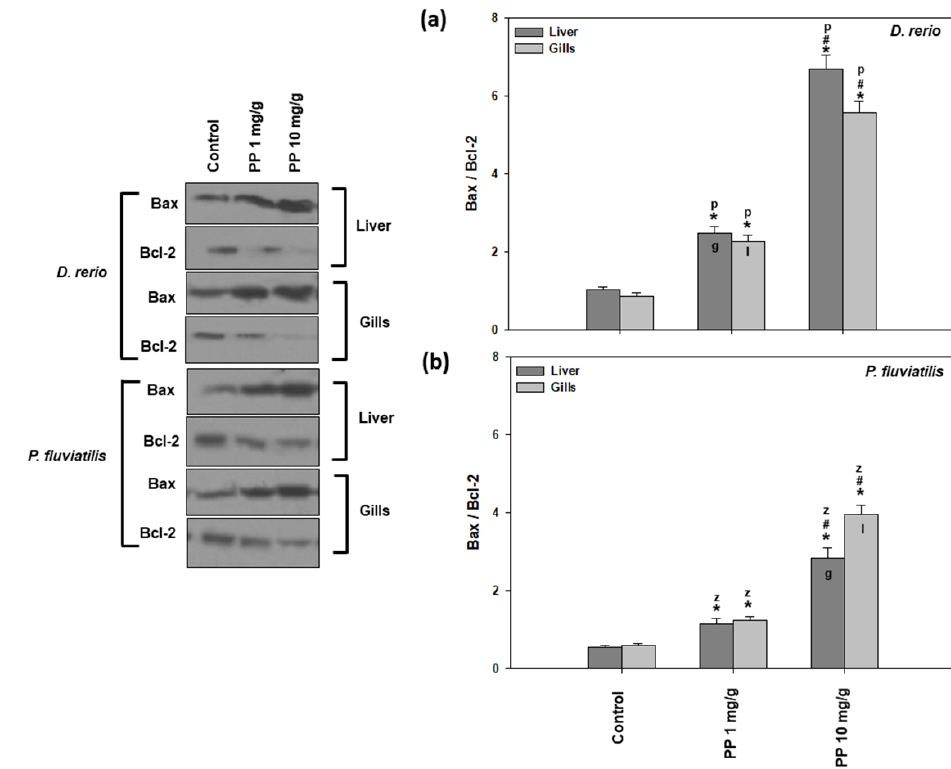
Figure 6. Bax/Bcl-2 ratio (mean ± SD) in the liver and gills of the Danio rerio ( a ) and Perca fluviatilis ( b ) control and dietary exposed to 1 mg PP-MPs/g and 10 mg PP-MPs/g dry food. Asterisk (*) denotes significant differences ( p < 0.05) compared to the control group, dash (#) denotes significant differences ( p < 0.05) between the two examined concentrations: 1 mg PP-MPs/g and 10 mg PP-MPs/g, lower case letters “z” and “p” denote significant differences ( p < 0.05) between the two examined species D. rerio and P. fluviatilis , respectively, while lower case letters “g” and “l” denote within species significant differences ( p < 0.05) between the gills and liver, respectively.